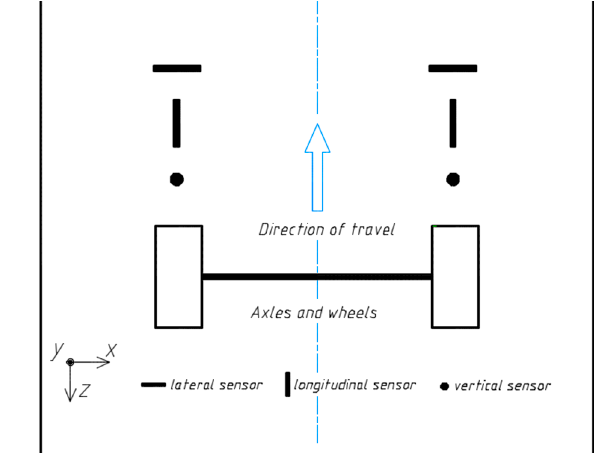
Figure 10. Top view of pavement, vehicles and sensors.